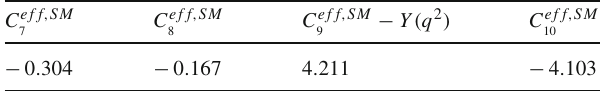
Table 1 At hadronic scale μ = m cients to NNLL accuracy